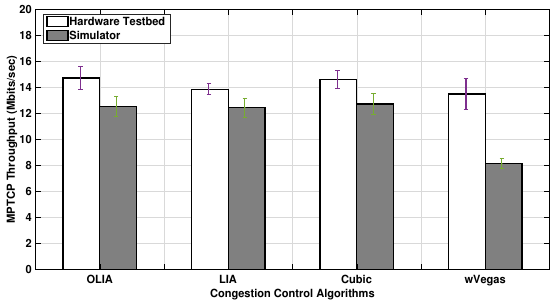
Figure 5. Setup 1 uplink MPTCP throughput for 20 MB flows.